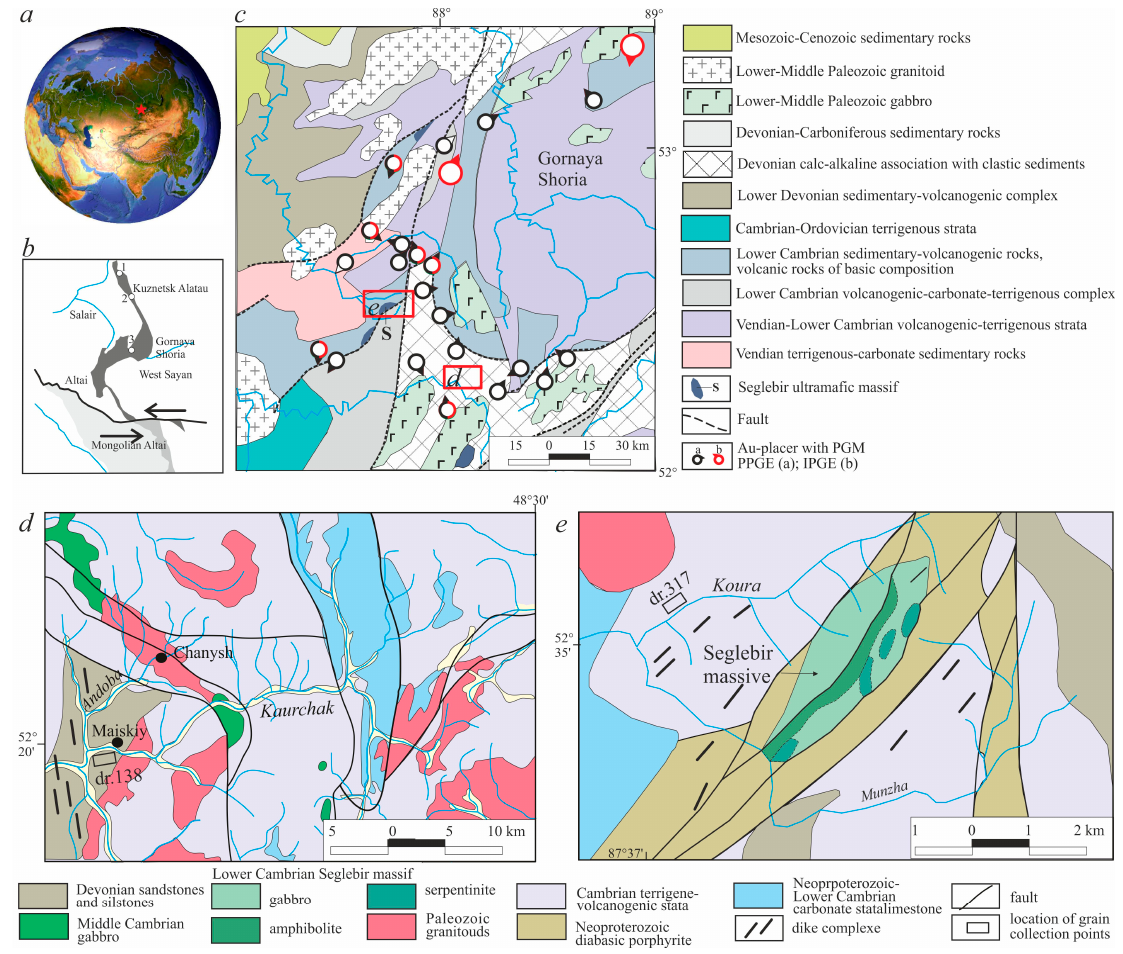
Figure 1. ( a ) Location of the study area; ( b ) the Kuznetsk Alatau–Gornaya Ghoria–Altai platinum-bearing belt is indicated by black color in the inset (modified from [20]): 1, Kaigadat massif; 2, Srednyaya Ters’ massif; 3, Seglebir massif and placers of Gornaya Shoria; ( c ) geological map showing the location of PGM and gold placers in the western Altai-Sayan folded area (Gornaya Shoria); ( d , e ) geological maps of catchment areas r. Kaurchak ( d ) and r. Koura ( e ).